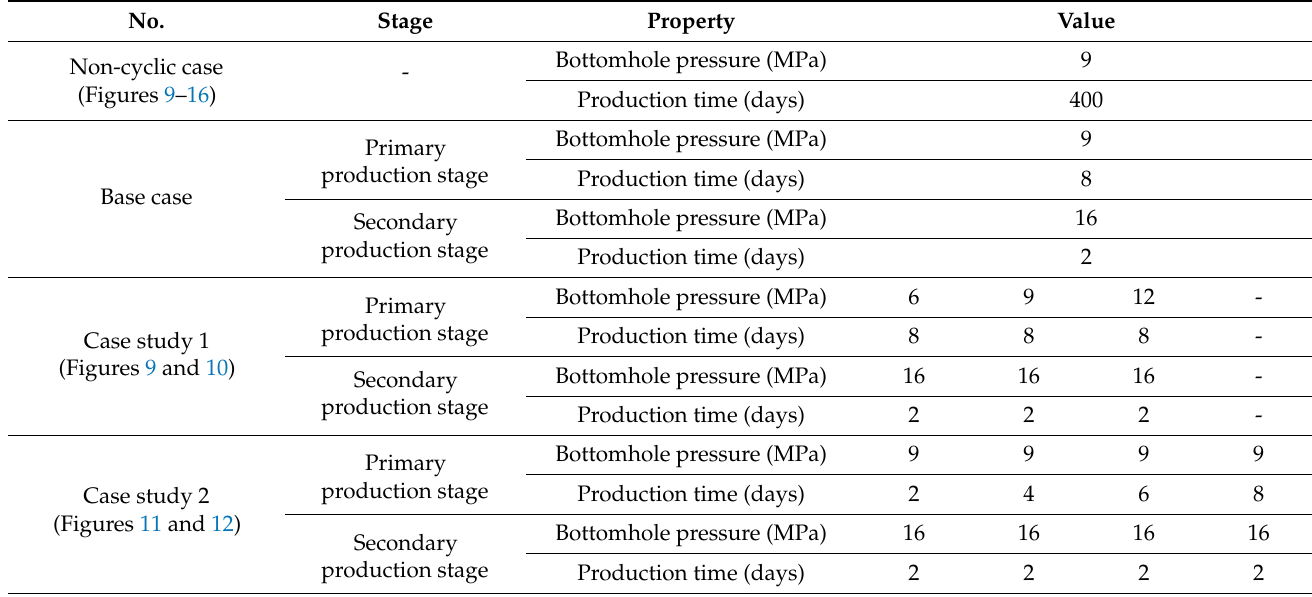
Table 4. Input data for the cyclic-depressurization case study.